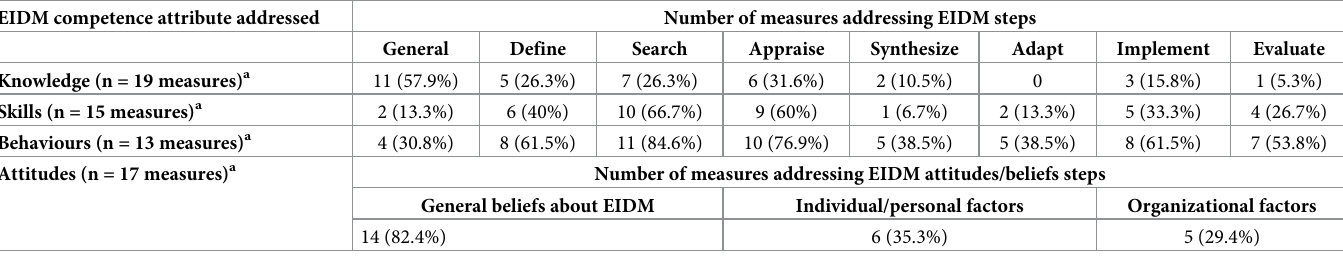
Table 1. Number (%) of EIDM knowledge, skills, behaviours, and attitude EIDM measures that address each of the EIDM